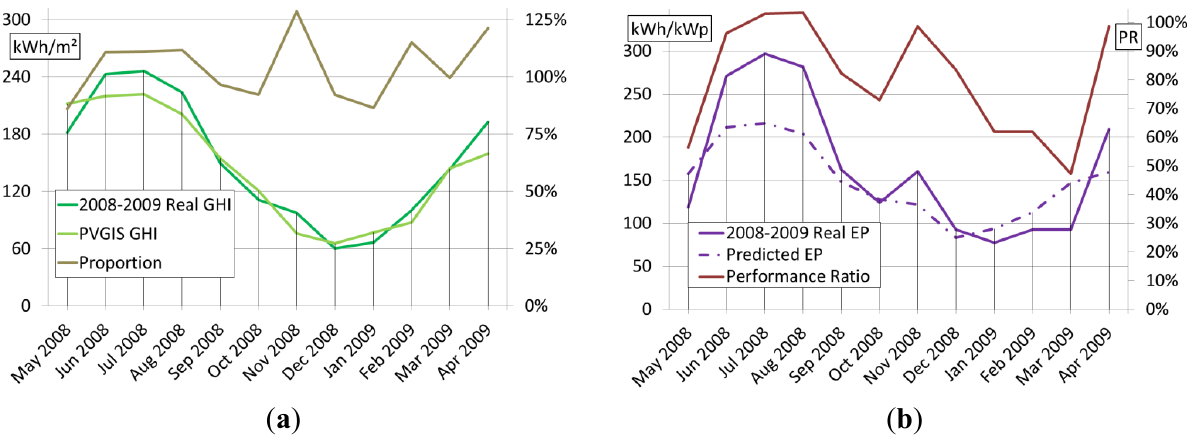
Figure 9. ( a ) PVGIS GHI, real weather station GHI, and ratio between them; ( b ) Real EP, EP prediction based on constant PR, and estimated PR values at the Sanlúcar la Mayor CPV installation for